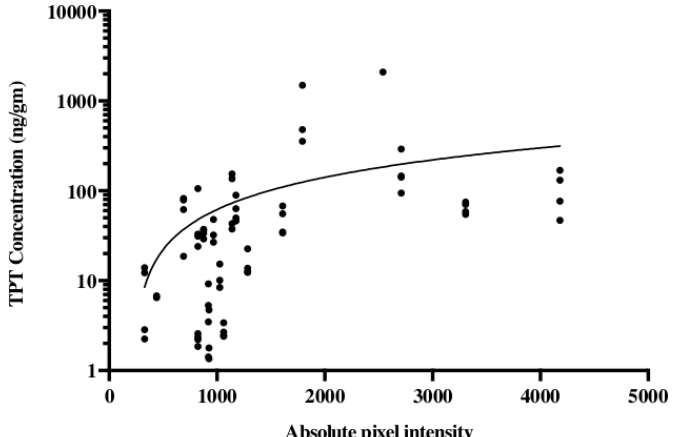
Figure 3. Topotecan concentration is correlated with the gadolinium absolute pixel intensity of T1 MRI. Studies were conducted in a porcine model using a subcutaneous pump that co-delivered topotecan and gadolinium. Liquid chromatography-mass spectrometry was used for the quantification of topotecan concentration and correlated with the absolute pixel intensity from T1-weighted MRI. The data are reproduced from D’Amico et al., 2019 [41].